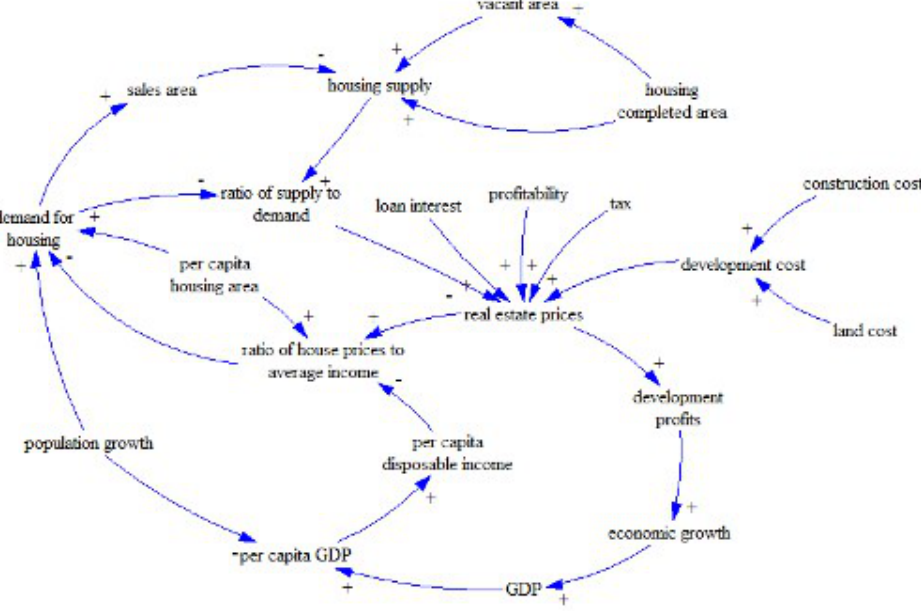
Figure 2. Causal loop diagram of the impact on the real estate